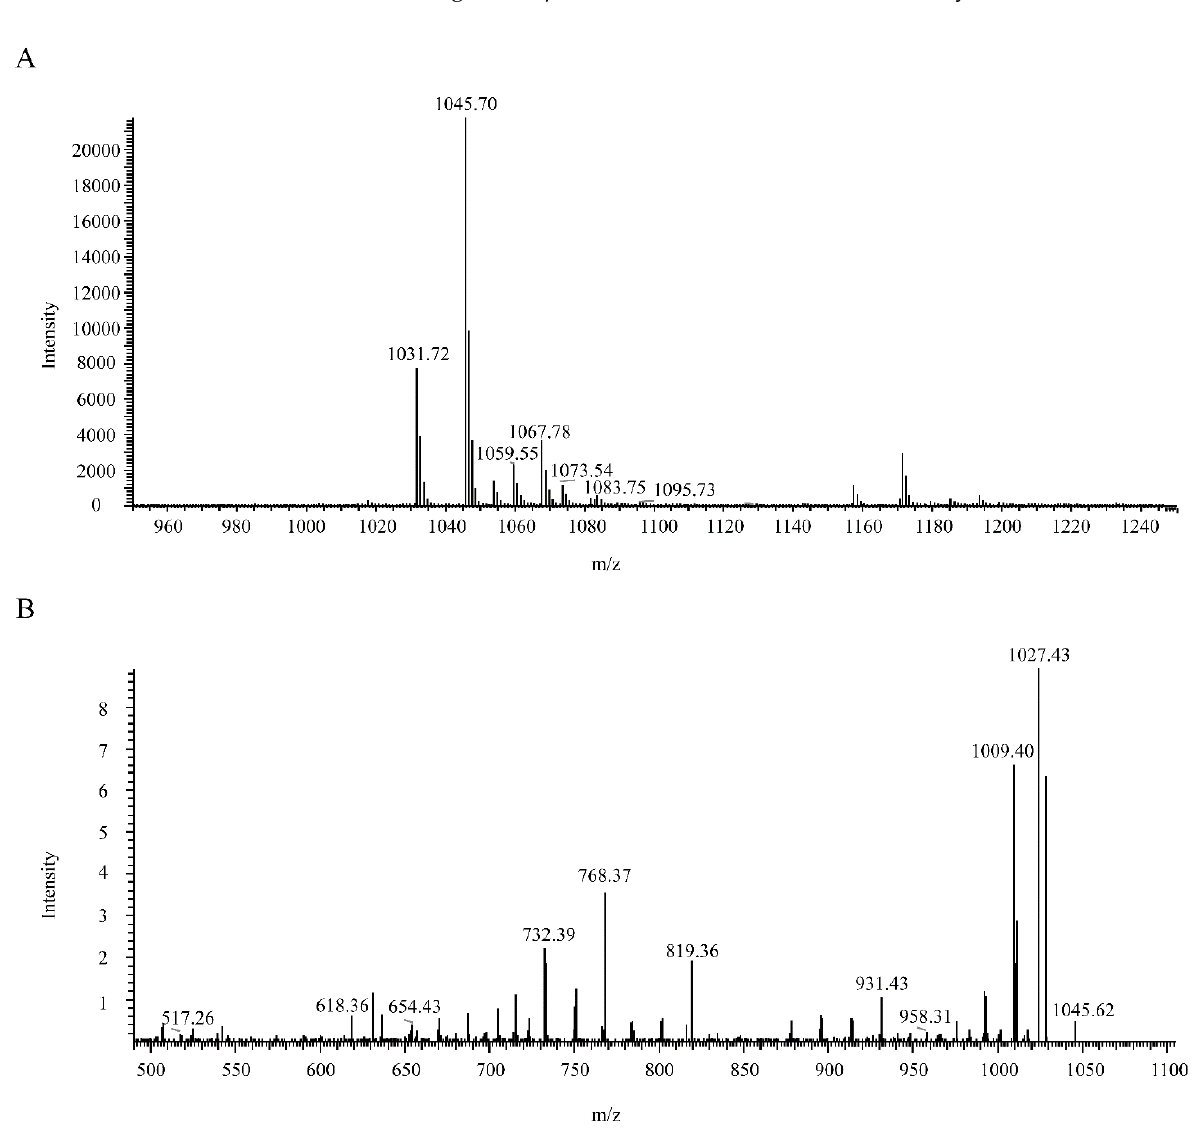
Figure 5. HPLC-ESI-MS analysis of the purified antagonistic compound from B. velezensis ATR2 against B. pumilus GR8 ( A ) and CID spectrum resulting from (M + H) + ion of m / z 1045.70 ( B ). ( A ), Ions of m / z 1031.72, 1045.70, 1059.55 and 1073.54 corresponded to bacillomycin D (M + H) + , ions of m / z 1067.78 and 1095.73 corresponded to bacillomycin D (M + Na) + , and ion of m/z 1083.75 corresponded to bacillomycin D (M + K) + ; ( B ), ion of m / z 1027.43 corresponded to (M + H − H 2 O) + , ion of m / z 958.31 corresponded to (M + H − Ser) + , ion of m / z 931.43 corresponded to (M + H − Asn) + , ion of m / z 819.36 corresponded to (M + H − Pro − Glu) + , ion of m / z 768.37 corresponded to (M + H − Tyr − Asn) + , ion of m / z 732.39 corresponded to (M + H − Pro − Glu − Ser) + , ion of m / z 654.43 corresponded to (M + H − Asn − Tyr − Asn) + , ion of m / z 618.36 corresponded to (M + H − Asn − Pro − Glu − Ser) + , and ion of m / z 517.26 corresponded to (M + H − Asn − Pro − Glu − Ser − Thr) +